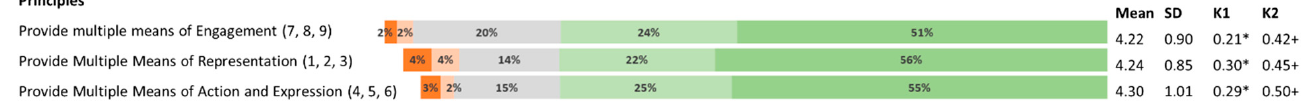
Figure 7. Principles evaluation results. Note: standard deviation (SD), Kappa for 5 values (K1); Kappa for 3 values (K2); fair agreement *; moderate, substantial, and perfect agreements +.To an- swer RQ1, Fleiss’ kappa values were computed for both K1 using the five Likert values in the questions, and K2 which reduced the evaluation to three options (disagreement, neutral, and agreement). For the 31 checkpoints using K1 scores there were: 11 slight, 17 fair, and 2 moderate agreements. In addition, the 31 checkpoints using K2 scores were: 6 slight, 5 fair, 17 moderate, and 2 substantial agreements. These results indicate that while the agreement for some items was achieved (i.e., 2.2. and 4.2), for other items, the responses among raters were variable (i.e., 1.1, 2.3, 2.4, 5.1, 5.3, and 8.2). The lower levels of agreement can be interpreted either as variable insights